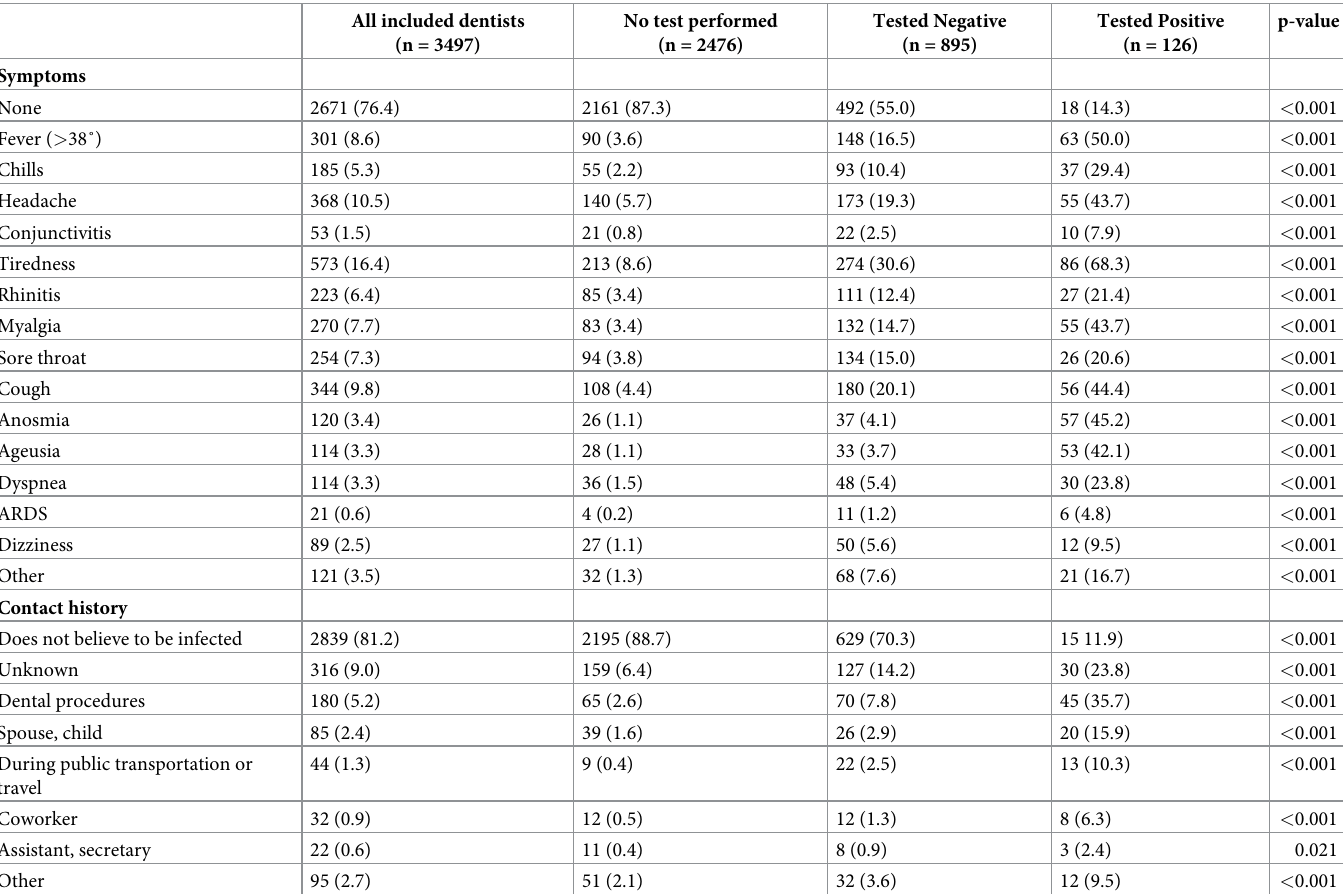
Table 2. Symptoms and putative exposure history in dentists.